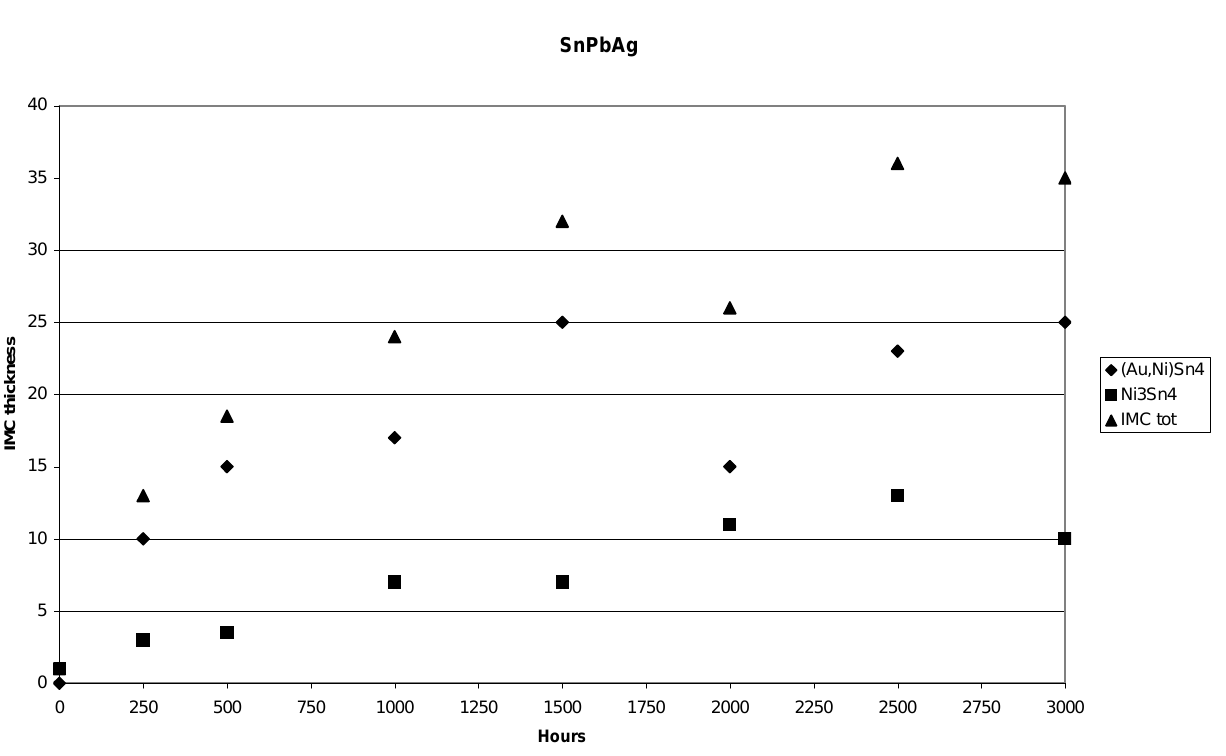
Figure 15. Plot of the IMC-thickness versus time in the (SnPbAg)/Ni/Au